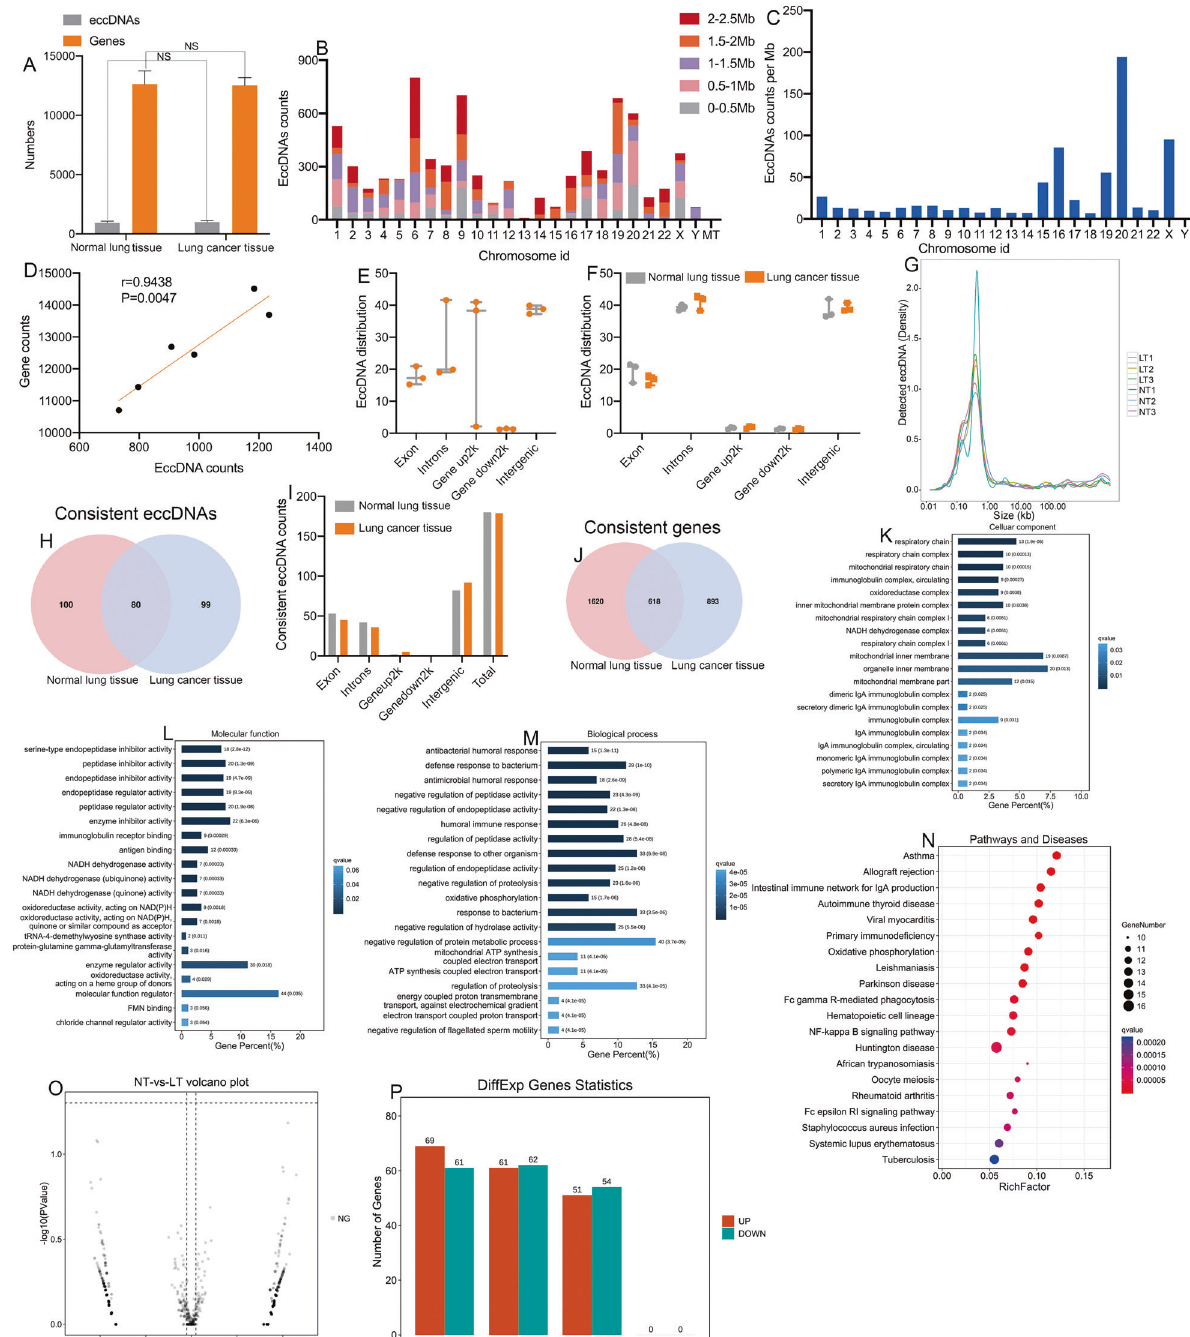
Fig. 1 Genome-wide detection and analysis of eccDNA distribution by high-throughput sequencing in matched NSCLC and normal samples. A The number of eccDNA types and involved genes from normal and NSCLC tissues. B The distribution of eccDNAs in the 23 pairs of chromosomes. C The eccDNA frequency per Mb in each chromosome. D There was a signi fi cant correlation between the number of coding genes in a given chromosome and the number of eccDNAs derived from the chromosome ( P = 0.047). E , F The distribution of eccDNAs in different classes of genomic regions. G The length distribution of eccDNAs ranged from 0.01 kb to 1000 kb. H A Venn diagram showing the consistent eccDNAs detected in the NSCLC and matched normal lung tissue samples. I The distribution of consistent eccDNAs in different classes of genomic regions. J A Venn diagram showing the consistent genes detected in the NSCLC and matched normal lung tissue samples. K – M The cellular components, molecular functions, and biological processes associated with the consistent eccDNAs. N KEGG pathway analysis of the consistent eccDNAs between NSCLC and matched normal lung tissue. O , P Volcano plot and histogram showing that there were no differentially expressed eccDNAs between NSCLC and matched normal lung tissues. EccDNA extrachromosomal circular DNA, NSCLC non-small cell lung cancer, Mb